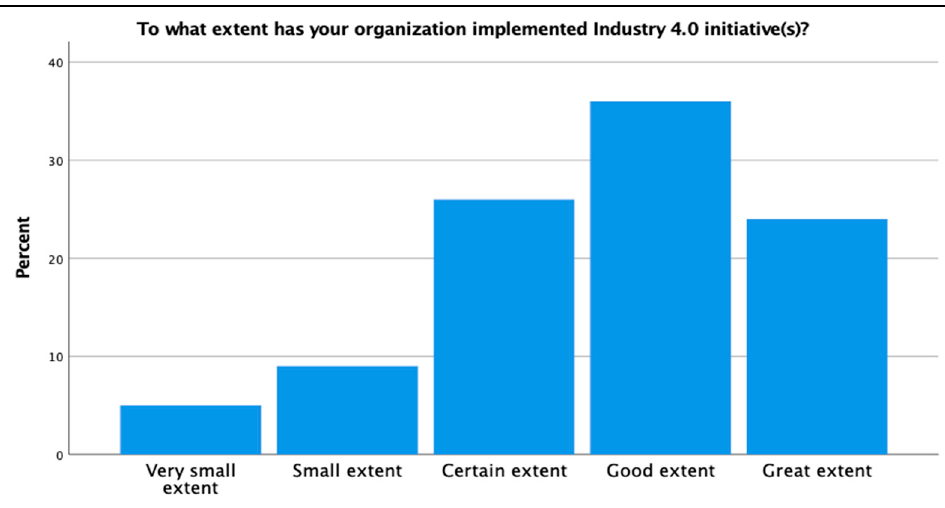
Figure 3 . Company Implementation Extent.